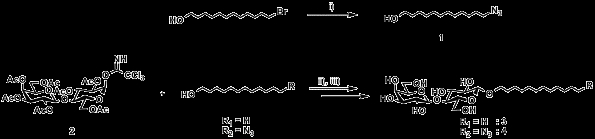
Synthesis of amphipathic lactosides. i) NaN3, DMSO, 80°C. ii) BF3·Et2O, ClCH2CH2Cl, 0°C. iii) NaOMe, MeOH, r.t.